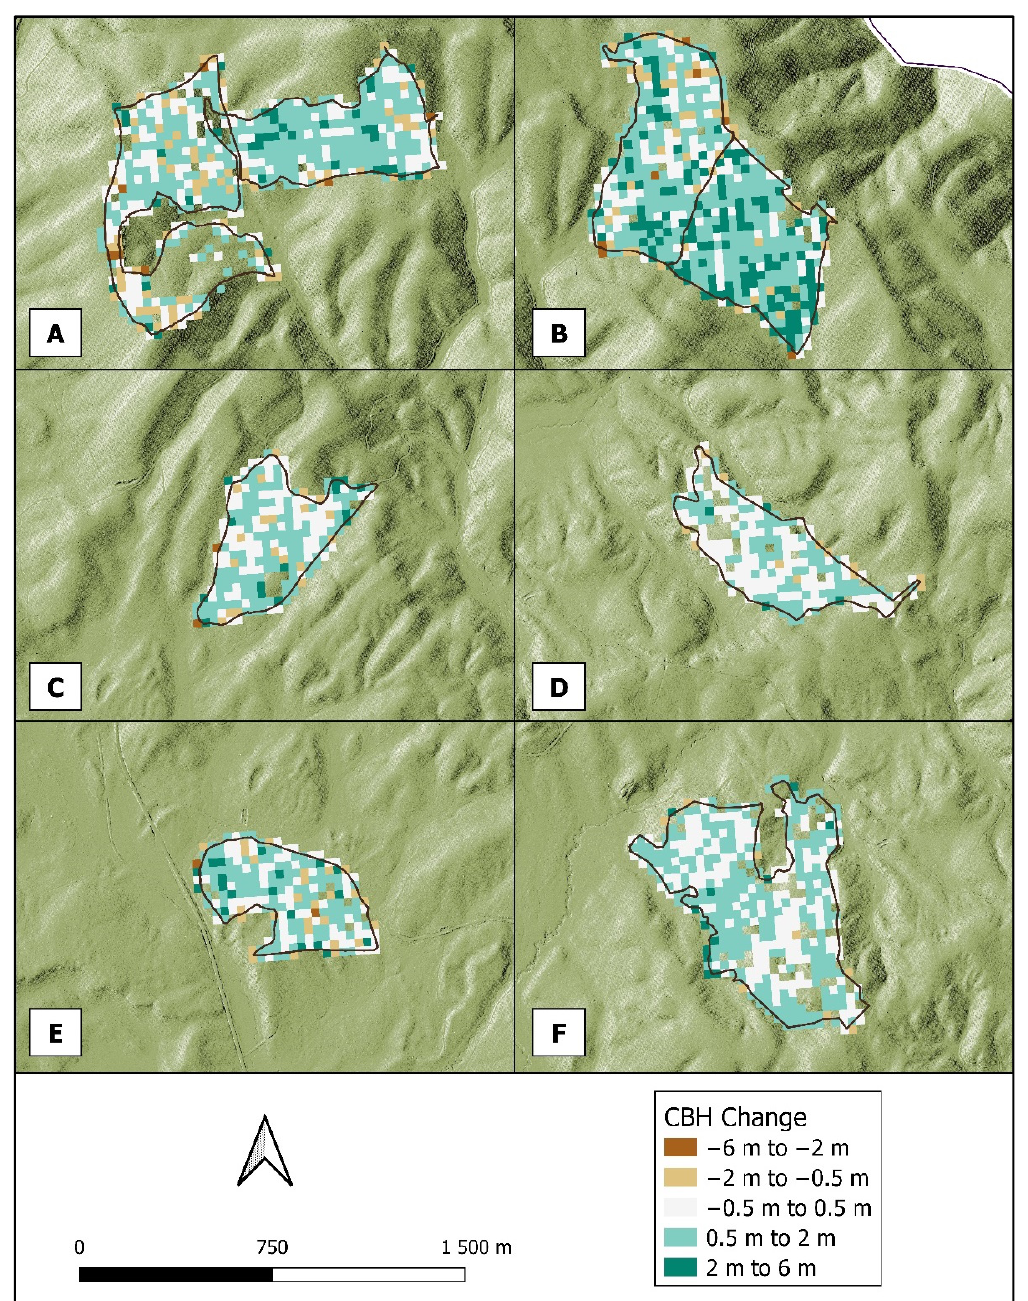
Figure 4. Predicted change in canopy base height in the sample units following fuel reduction treatments. ( A ) Mixed conifer TH (left) and mixed conifer NT (right). ( B ) Mixed conifer TB (left) and mixed conifer BU (right). ( C ) Ponderosa TH. ( D ) Ponderosa NT. ( E ) Ponderosa TB. ( F ) Ponderosa BU. Table 2. Average Canopy Base Height (CBH) by sample stand pre-/post-treatment with average 10- year change/range.